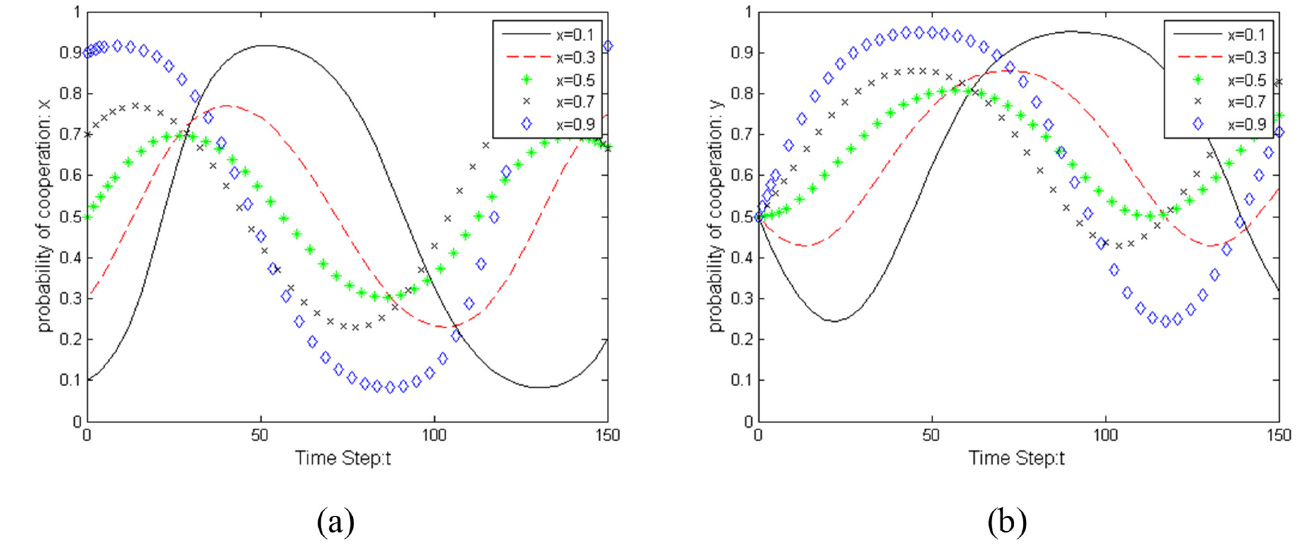
Figure 4. Evolution simulation, Scenario 4: ( a ) RDP; ( b ) hydropower developer.